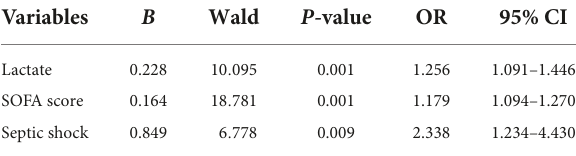
TABLE 4 Multivariate analysis with logistic regression in the two